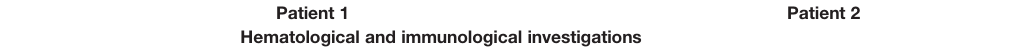
TABLE 1 | Results of the investigations and comparison between the patients. Patient 1 Patient 2 Hematological and immunological investigations █ Severe thrombocytopenia: 27 × 10 9 L (reference values: 200 –